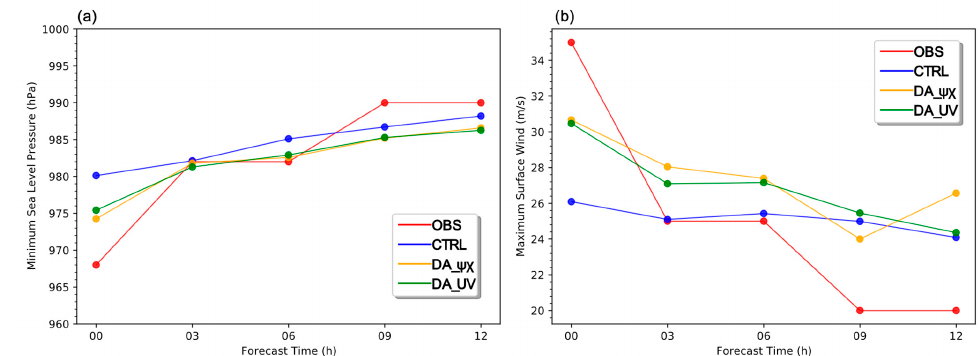
Figure 12. The ( a ) MSLP and ( b ) MSW of observation and three experiments during forecast